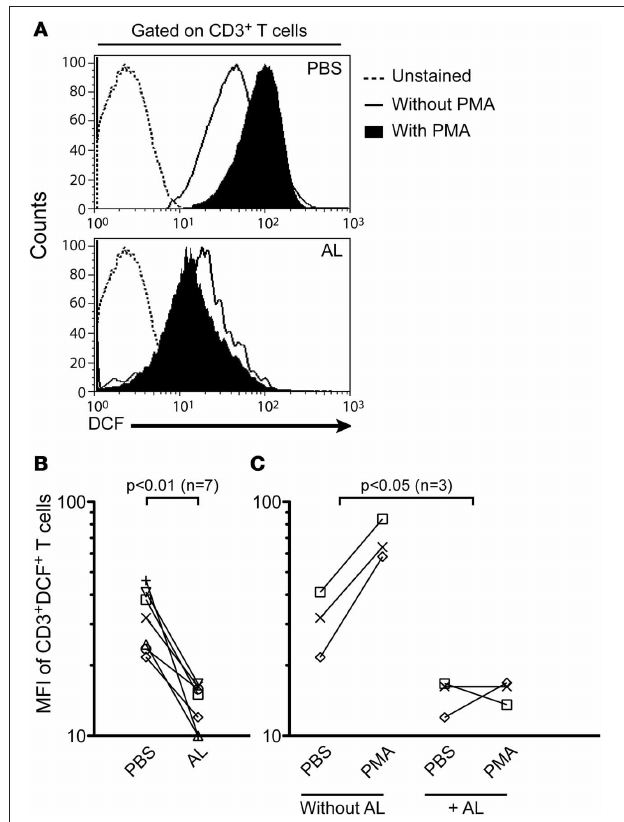
FIGURE 4 | Allopurinol attenuates spontaneous and mitogen-activated iROS production in human T cells. PBMC were stained with anti-CD3 PE and incubated at 37 ◦ C for 1h with DCFH-DA and PBS alone or with PMA (100nM) in the presence ( + AL, 300 μ g/ml) or absence of allopurinol. The oxidized form, DCF represents a measure of iROS. Lymphocytes were gated by forward and side light scatter. From this population single color CD3 staining histogram was made, and the expression of DCF in the gated population was analyzed. (A) Representative iROS expression on CD3 + T cells in the absence (upper panel) or presence (bottom panel) of allopurinol. (B) Cumulative data of spontaneous iROS production from 7 subjects. Each line represents spontaneous iROS levels for each patient in the absence (PBS) or in the presence (AL) of allopurinol. (C) Cumulative data of induced iROS production. Each line show iROS release for each subject prior and following stimulation with PMA in the presence ( + AL) or absence of allopurinol. Comparisons were performed by Wilcoxon signed rank test. MFI: mean fluorescence